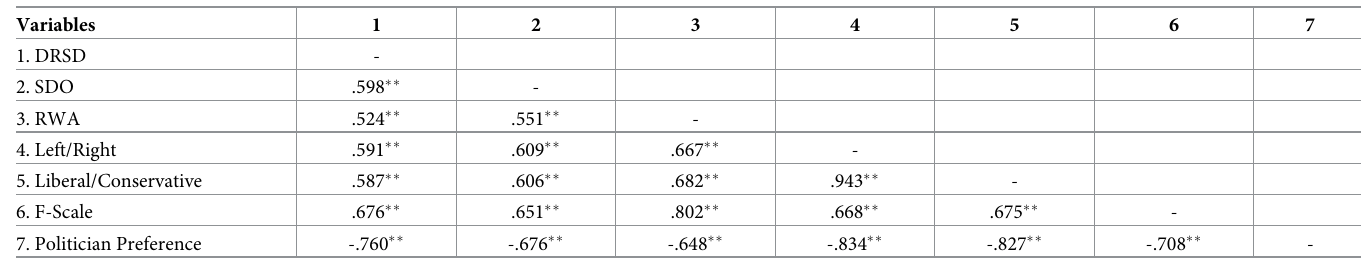
Table 5. Correlations Study 2.